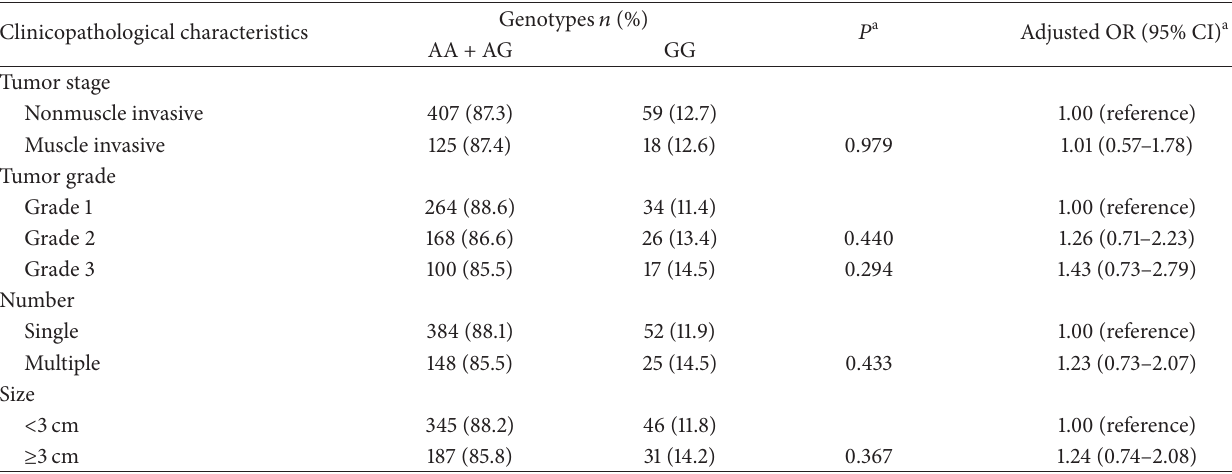
Table 5: TSP-1 -1223 A/G polymorphism and clinicopathological characteristics in patients with bladder cancer.